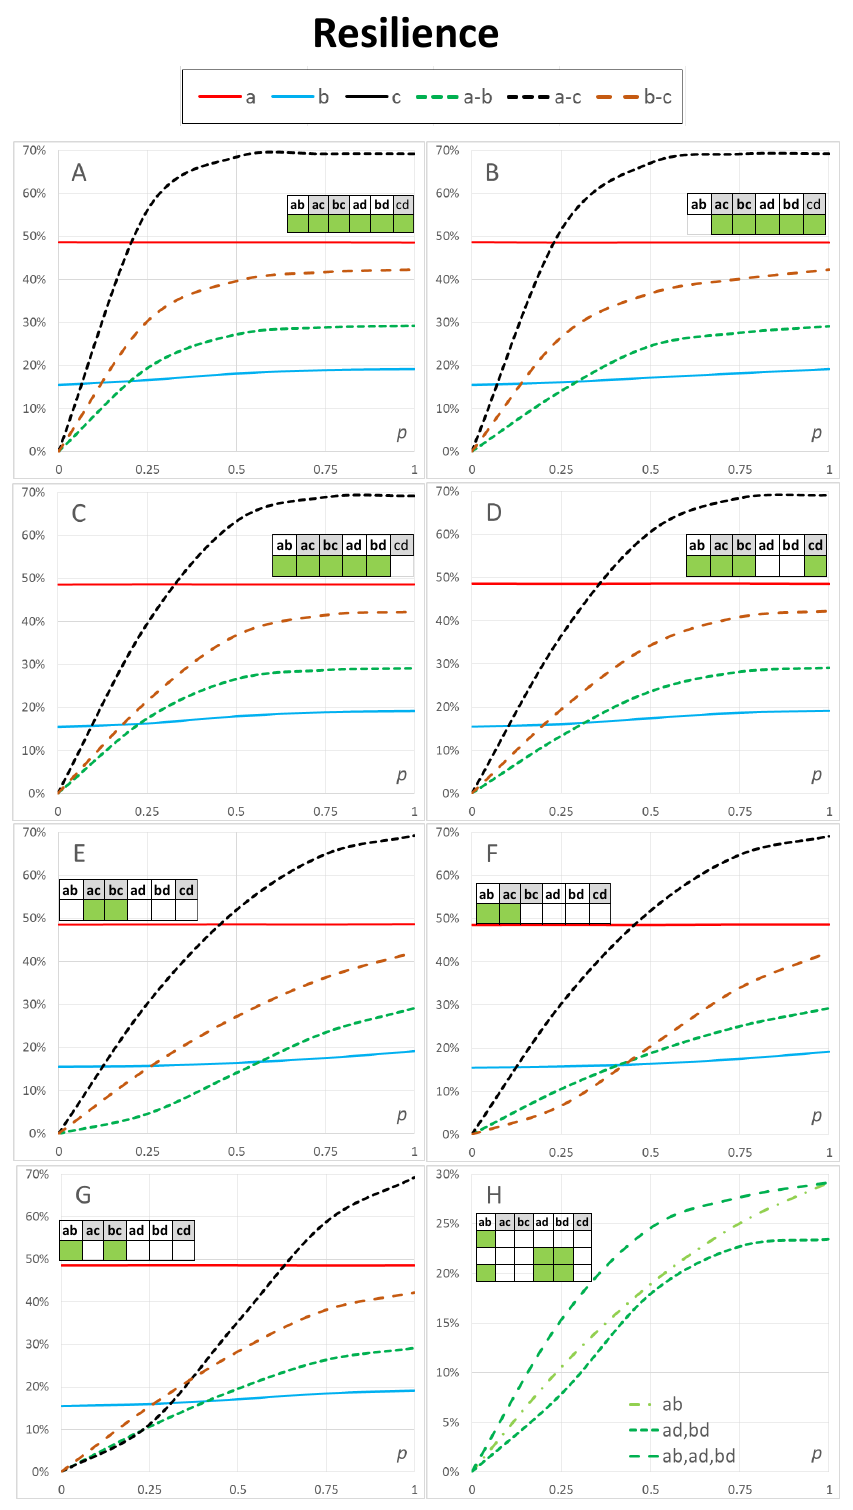
Figure 3. Resilience of the multilayer communication system of Figure 1 with different resilience levels of communication between networks. Resilience values (probability of sufficient resilience) in each network are shown by solid lines a, b and c. Dashed lines a–b, a–c and b–c show corresponding resilience values between different networks. In this figure, the resilience between nodes within a network is kept constant and the resilience of connections between networks is varied (horizontal